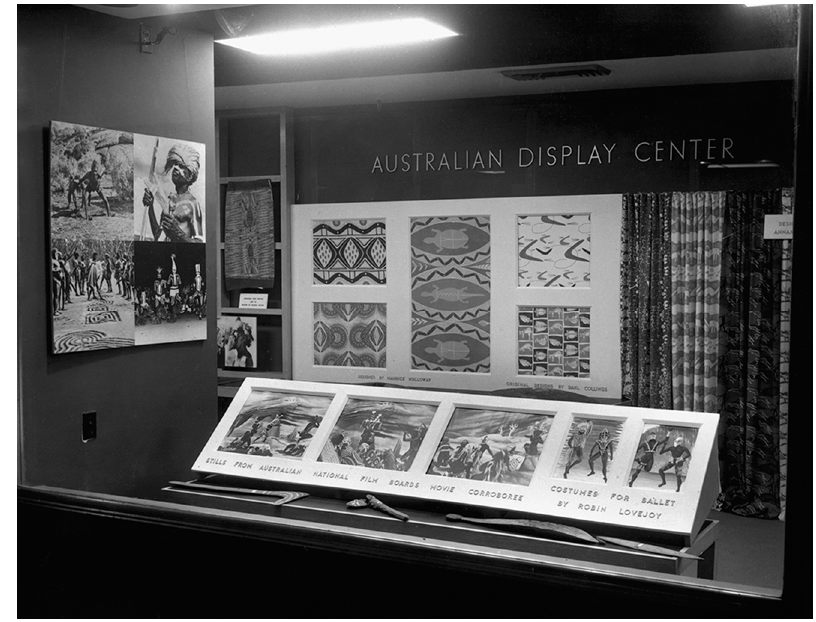
Figure 3. Photographs of Aboriginals and Aboriginal-inspired, design displays at the Australian Trade Commission at the Rockefeller Centre in New York, image courtesy the Museum of Applied Arts and Sciences, Sydney.